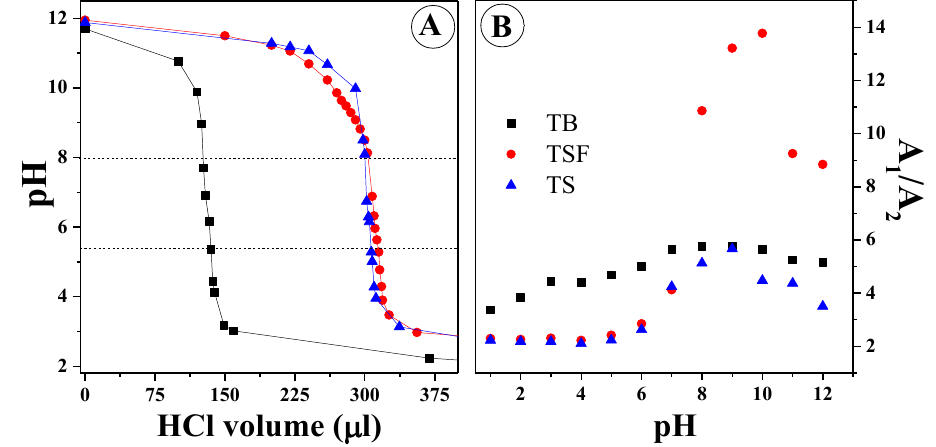
Figure 2. ( A ) pH-metric titration curves for TB (black squares), TSF (red circles), and TS (blue triangles). Titration was carried out with the use of 1 M HCl. ( B ) The ratio of the maximum electron spectra at c. 309/330 nm for TB, TSF, and TS relative to changes in the pH of the aqueous solution.